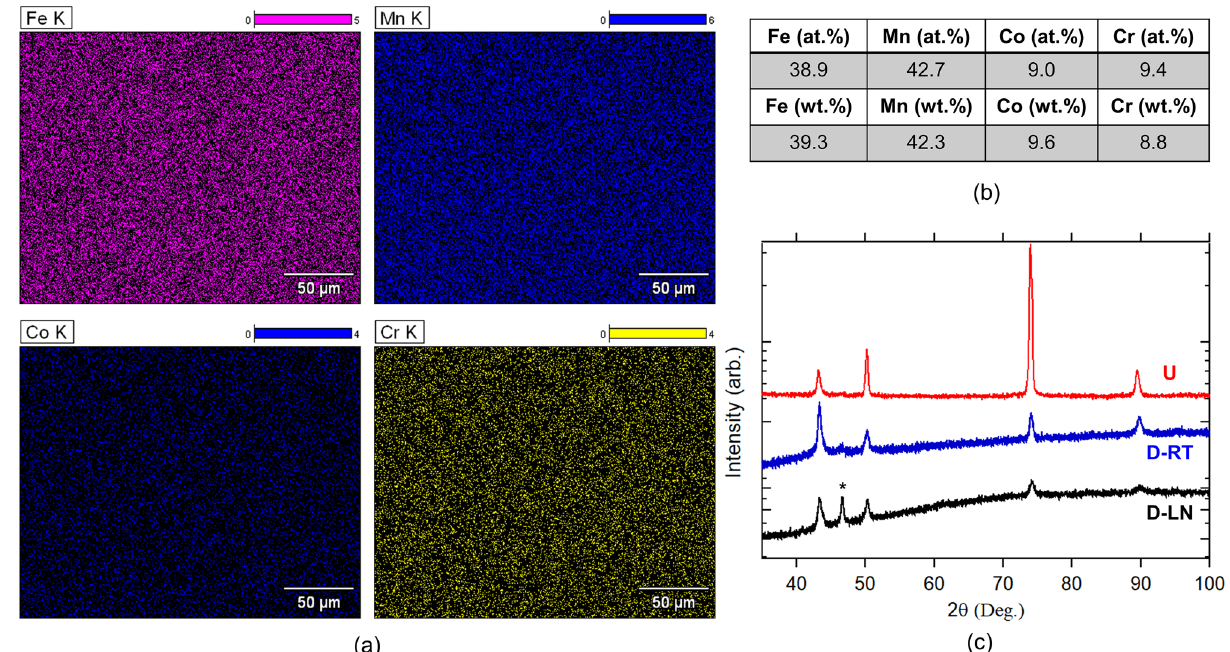
Figure 1. ( a ) Electron dispersive X-ray elemental composition area maps for constituent elements. ( b ) Atomic and weight distributions of the constituent elements. ( c ) X-ray diffraction data for pristine (U) and deformed samples. HCP peaks are marked